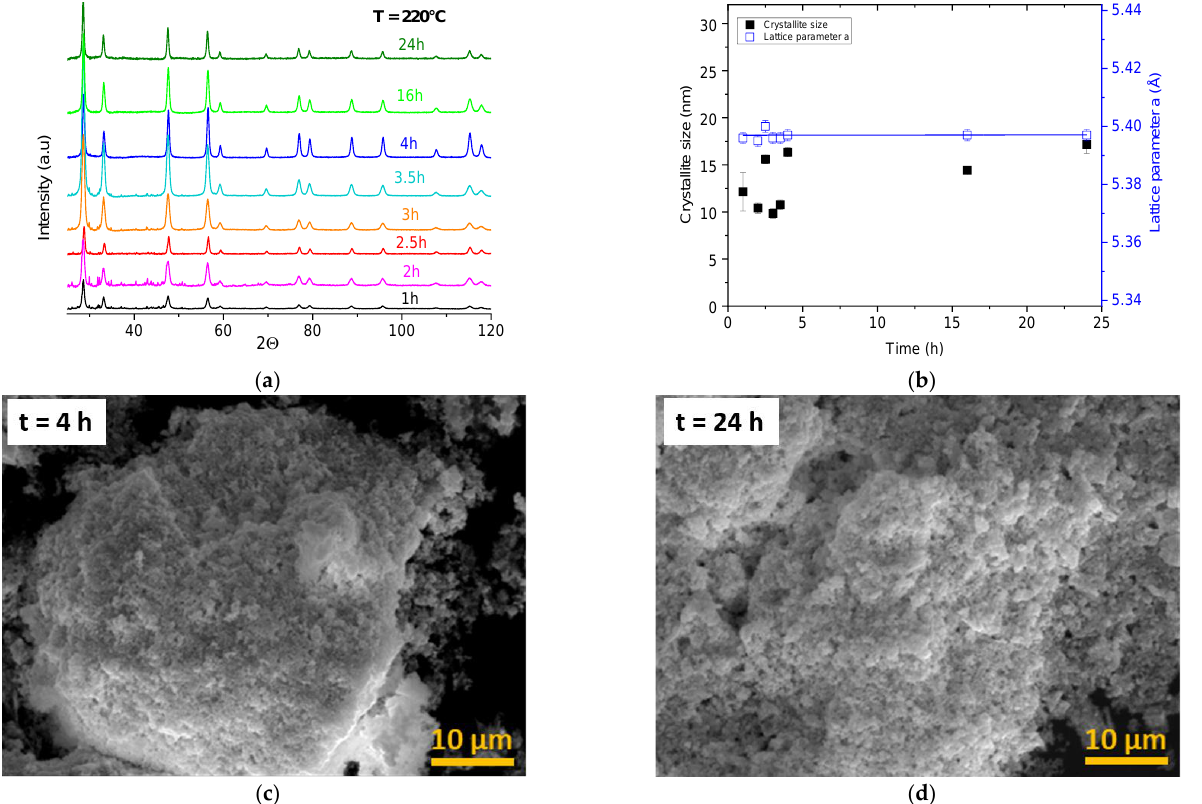
Figure 3. ( a ) Evolution of XRD patterns obtained for samples after hydrothermal conversion of Pu(C 2 O 4 ) 2 ·6H 2 O at the temperature of 220 °C for different durations; ( b ) variation in the crystallite sizes and lattice parameter with the reaction time ( c , d ); scanning-electron micrographs of PuO 2 nanoparticles prepared after hydrothermal treatment for 4 and 24 h.